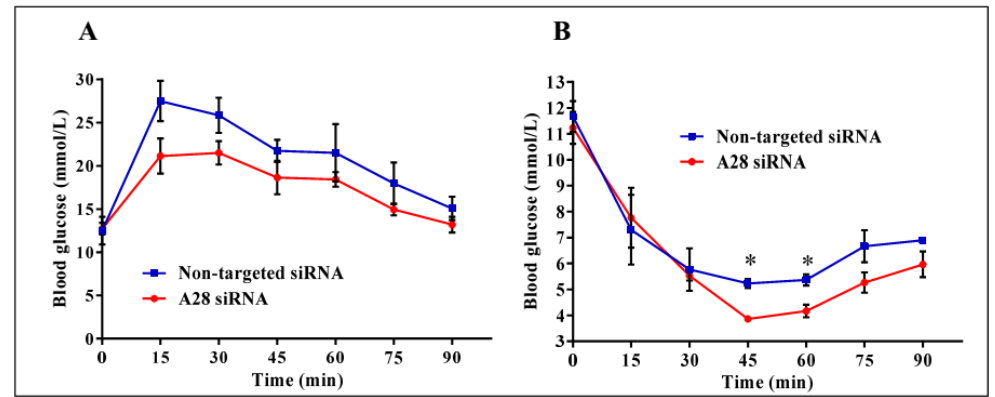
Figure 6. In vivo knock-down of mouse ADAM28 reduces high fat diet-induced mean weight gain. ( n = 3 mice/group).